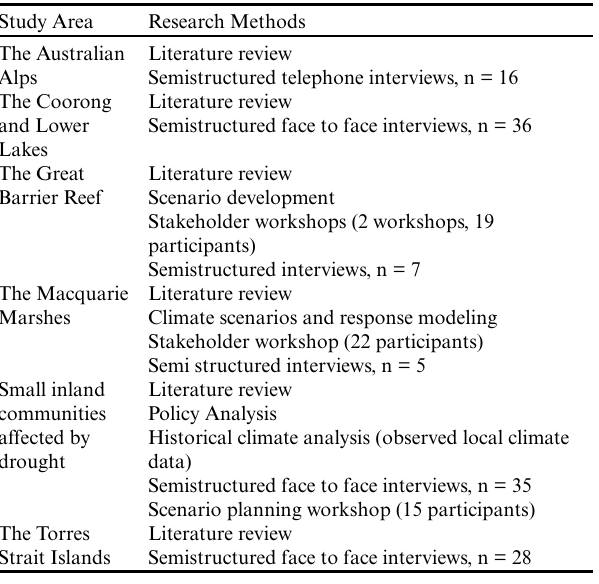
Table 2. Methods used in each case